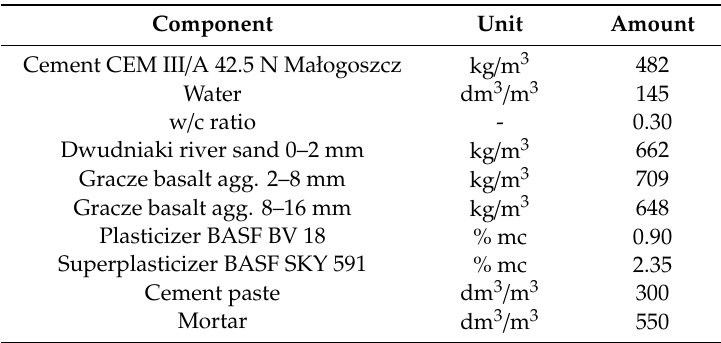
Table 1. Compositions of the tested concrete.